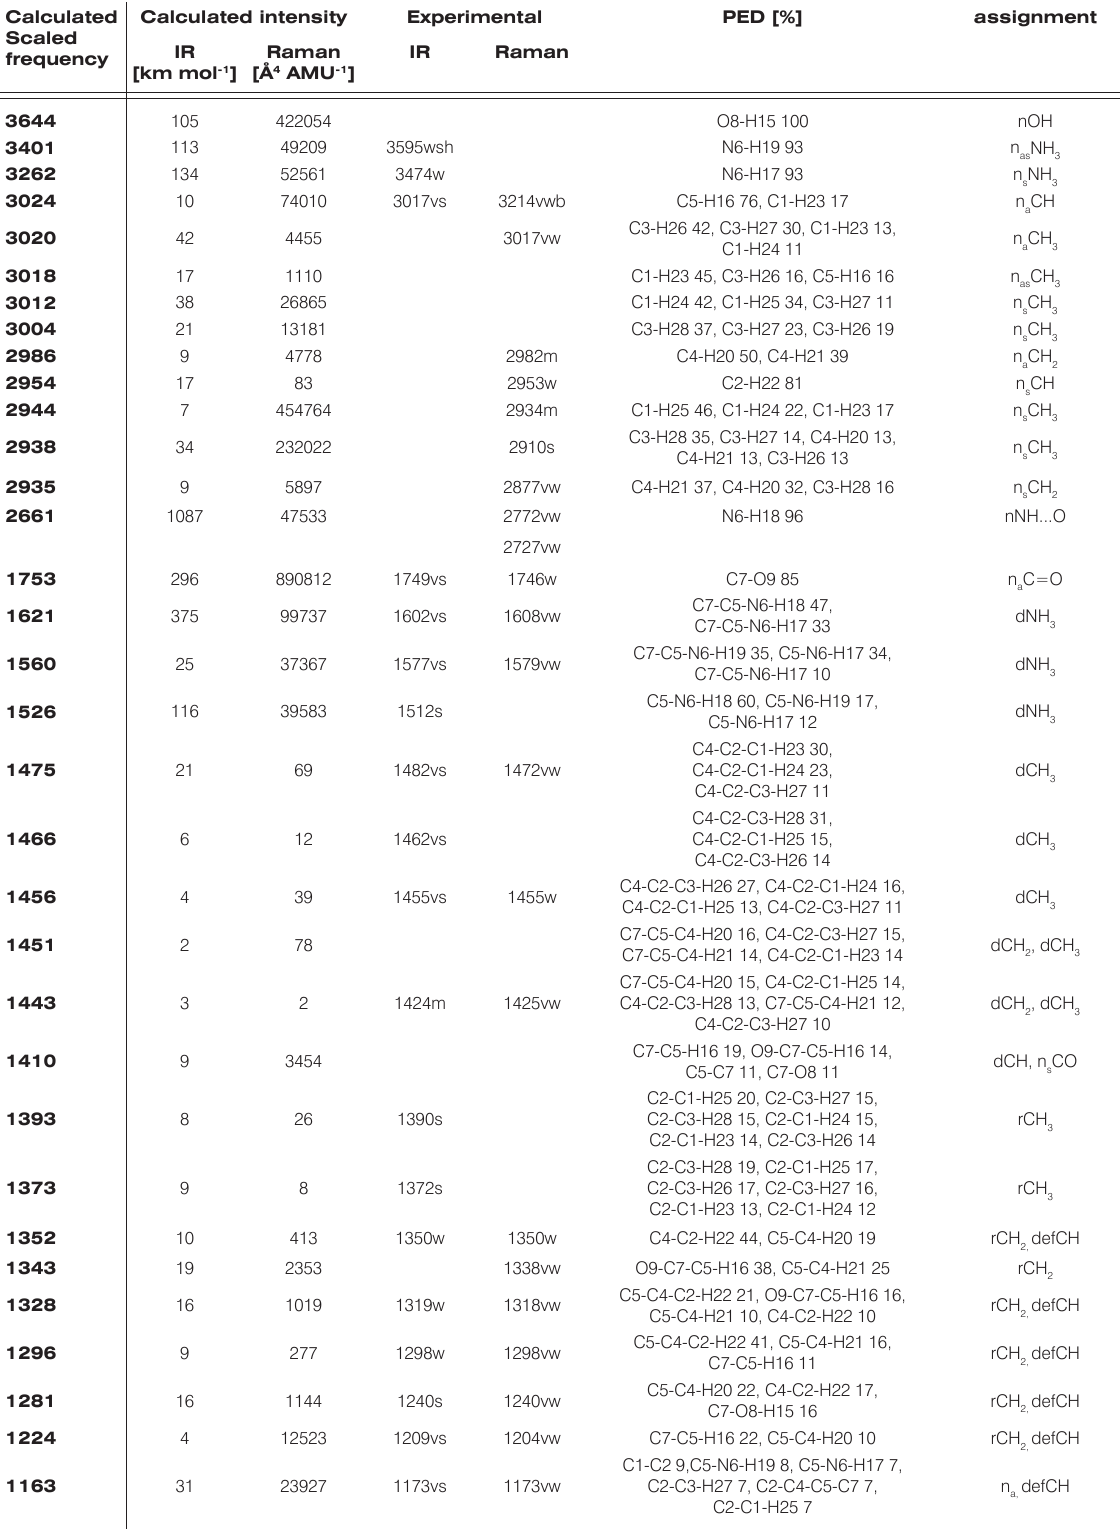
Table 4. Calculated frequencies and PED